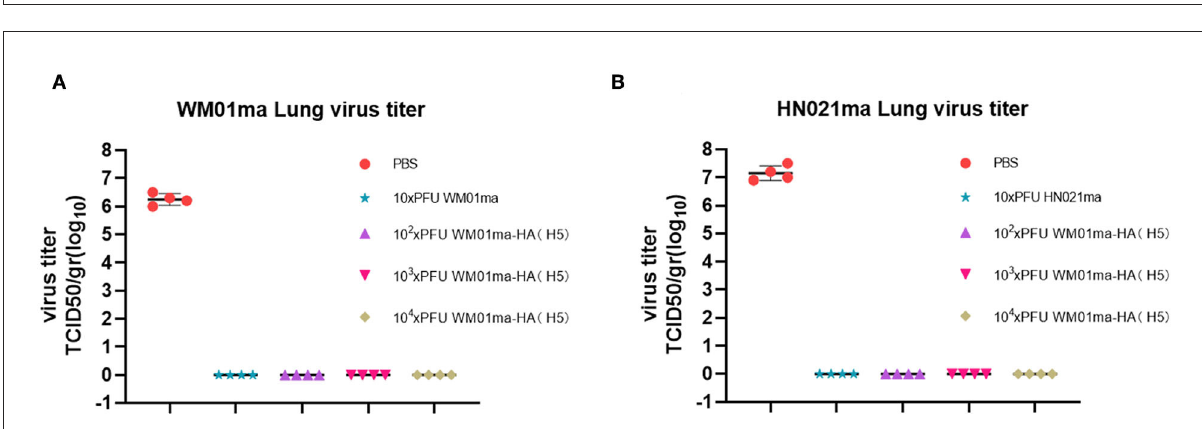
FIGURE9 The viral titration in the lung tissues of WM01ma (A) or HN021ma (B) challenged mice at 4 d.p.i. Each experiment was performed in quadruplicate. The dots correspond to the values obtained from the individual mouse values and are represented as the means ± SD.